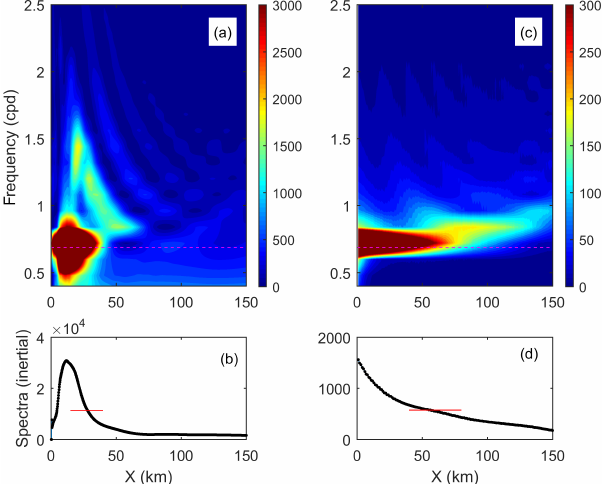
Figure 9. (a) Spectra of the temperature at the mid-depth ( z = − 30m). The pink dashed line represents the inertial frequency. (b) Sum of spectra in the inertial band with a red line denoting the e-folding value of the peak. (c) Theoretical spectra of mid-depth elevation calculated from the solution in the form of a Bessel func- tion as in Eq. (3.16) of Pettigrew (1981). (d) Same as (b) but for theoretical spectra.